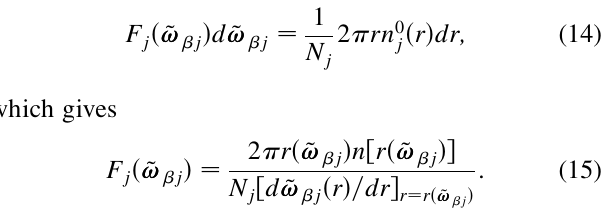
electrons.FIG. 5. Local transverse oscillation frequencies for the (a) protons and (b)